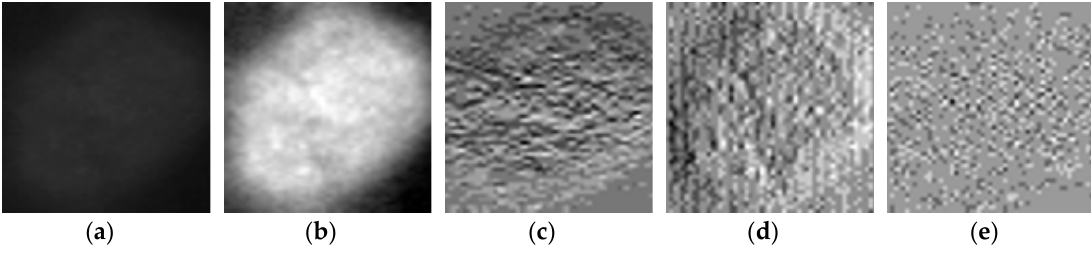
Figure 4. Negative intensity Fine Speckled cell: ( a ) Original image; ( b ) the approximation; ( c ) the horizontal detail; ( d ) the vertical detail; ( e ) the diagonal detail. The original image has a size of 112 × 112. The outputs of the DWT are all downsized by half (56 × 56). All the images in the figure were identically resized for the purpose of visualization.